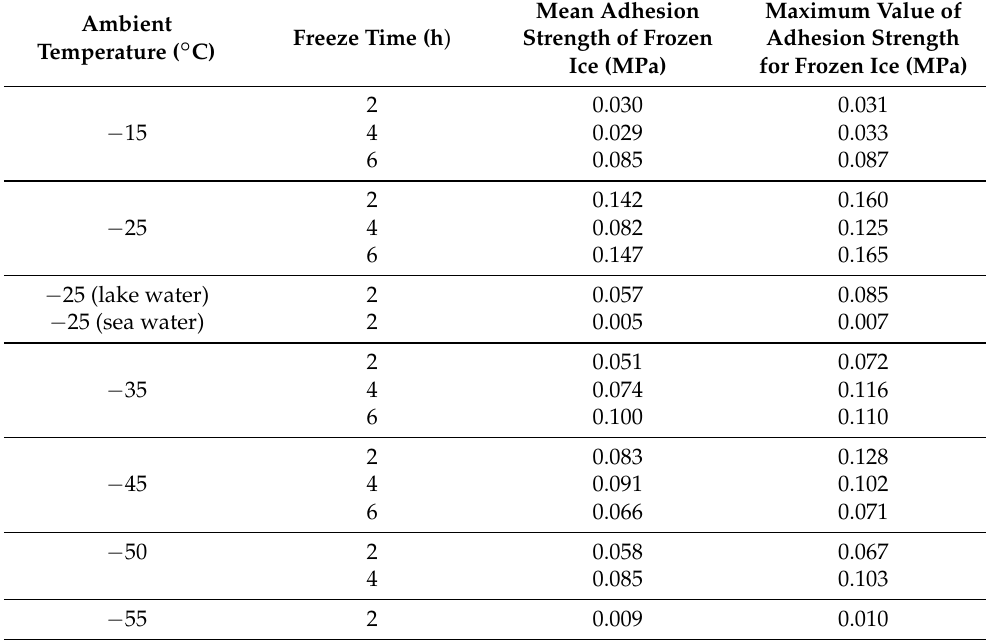
Table 8. Ice-breaking load of AL-Ice-SR specimens in shear tensile